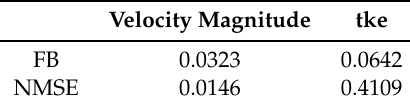
Table A5. FB and NMSE between experiment and simulation for the case with 3D canyons in Section